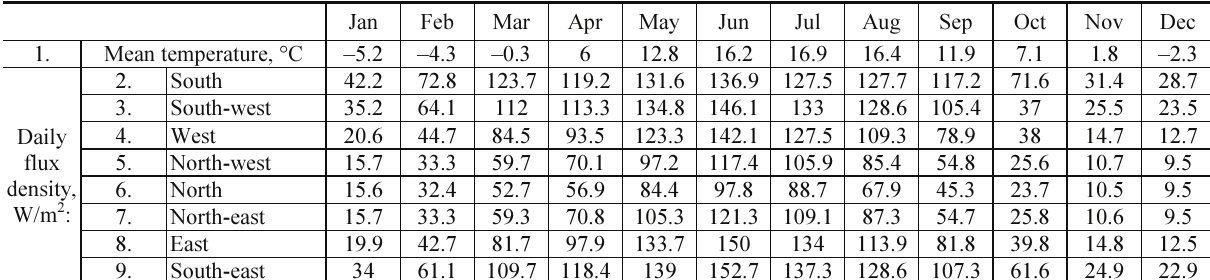
Table 1. Climate. Mean monthly outside air temperature and daily solar radiation flux density for Kaunas, Noreikiskes (RSN 156-94 (1995))